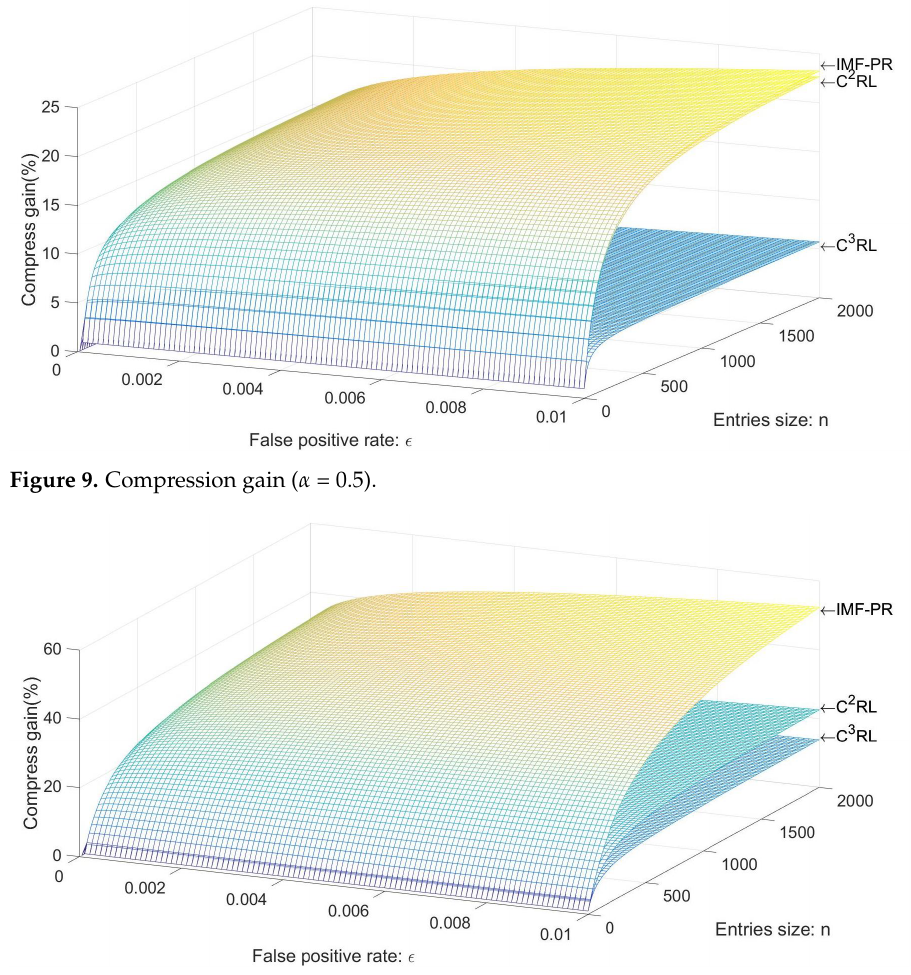
Figure 10. Compression gain ( α =